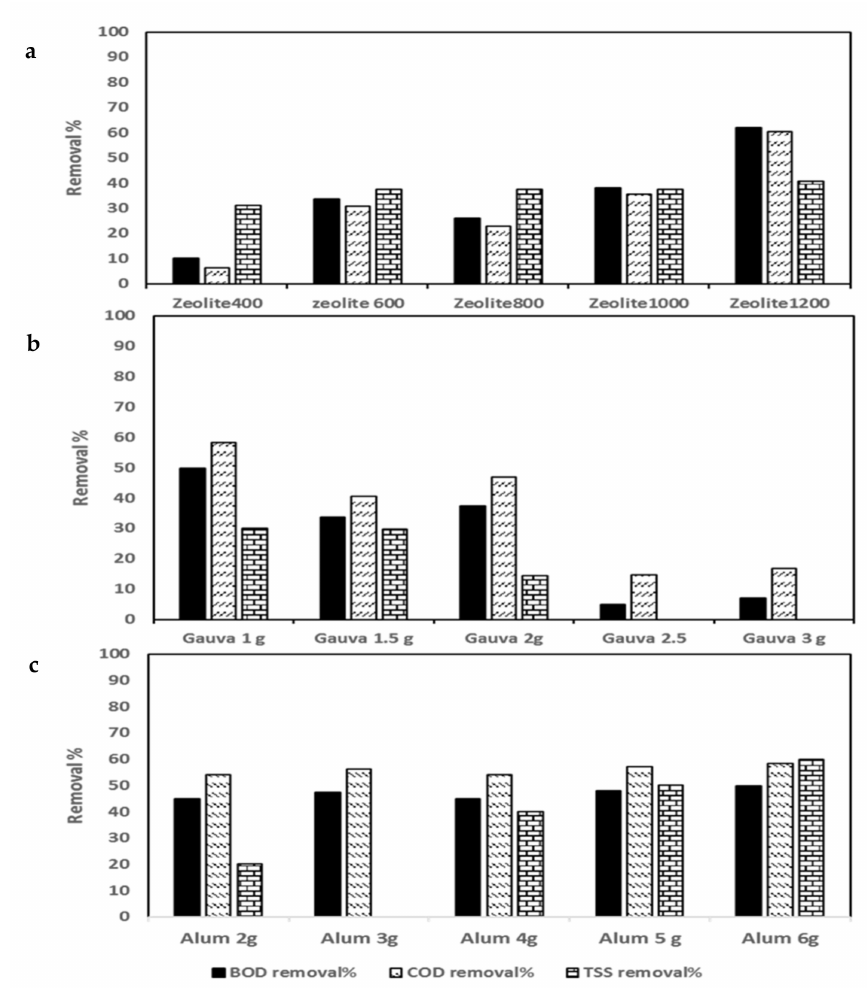
Figure 3. Chemical oxygen demand (COD), biological oxygen demand (BOD), and total sus- pended solids (TSS): Contaminant removal efficiencies of wastewater by coagulation processes using: ( a ) zeolite, ( b ) guava-leaf powder (GLP), and ( c )